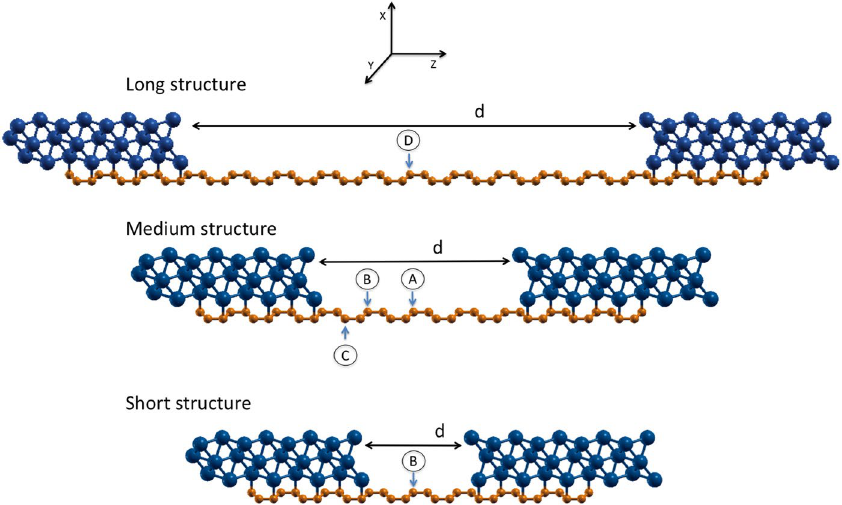
Figure 2. Structures investigated with ab-initio simulations include two metallic (nickel in the picture) regions connected by one graphene region of different lengths: a long structure (LS), where d = 4.53 nm for Ni/Cu systems and 5.02 nm for Pt/Pd systems (corresponding to a graphene region of 41 carbon atoms or 47 carbon atoms, respectively), a medium structure (MS), where d = 1.94 nm for Ni/Cu systems and 2.43 nm for Pt/ Pd systems (corresponding to a graphene region of 17 carbon atoms or 21 carbon atoms, respectively), and a short structure (SS), where d = 1.08 nm for Ni/Cu systems and 1.57 nm for Pt/Pd systems (corresponding to a graphene region of 9 carbon atoms or 13 carbon atoms, respectively). Transport is computed by cutting the structure at one of the points indicated, and by attaching semi-infinite metal and graphene leads, as in Fig. 1(b), on the left and the right, respectively.